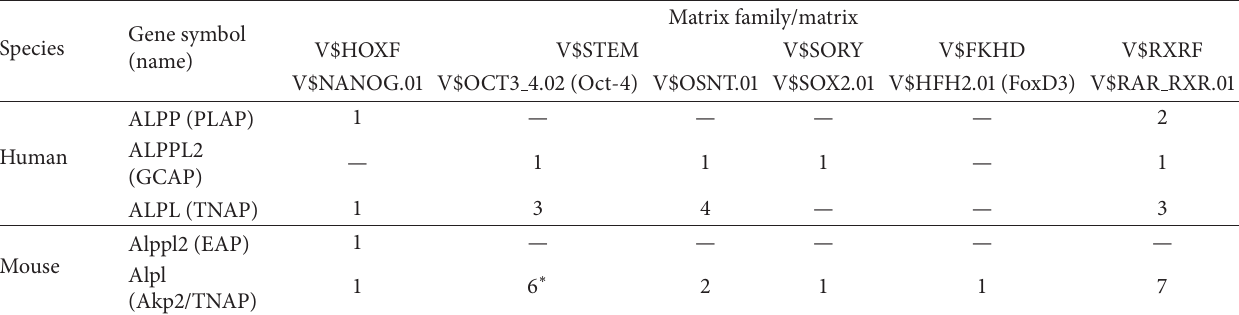
Table 2: Transcription factor binding site (TFBS) analysis of promoters of tissue nonspecific alkaline phosphatase isoforms. Gene Species